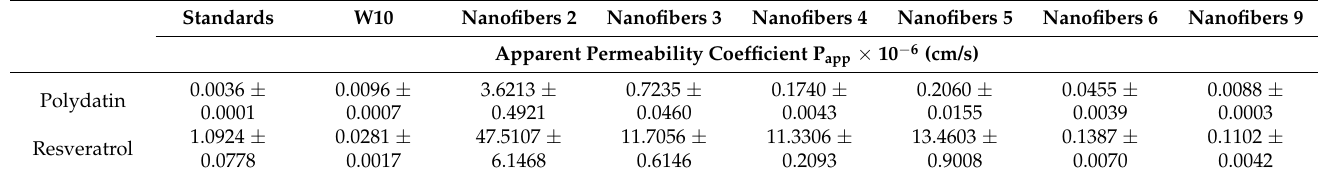
Table 8. Apparent Permeability Coefficients for Standards, as well as Active Compounds from Extract W10 and